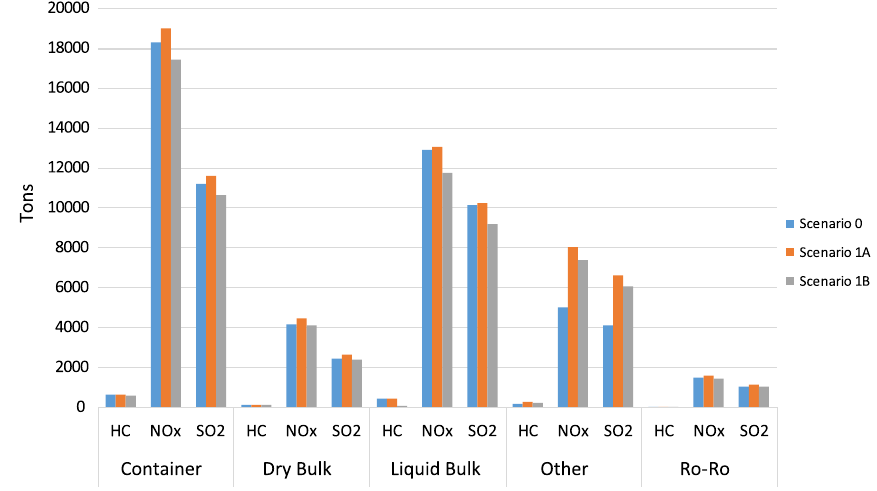
Fig. 6 Emissions of HC, SO 2 e NO x . Scenario framework